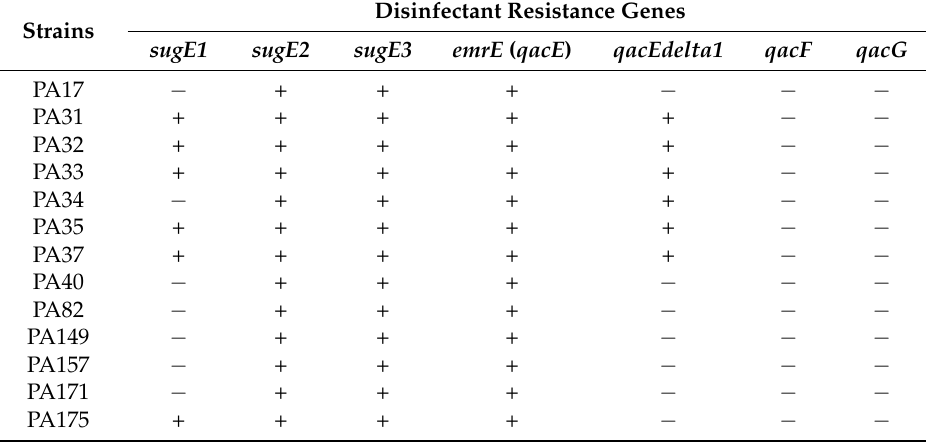
Table 1. Distribution of different disinfectant resistance genes in P. aeruginosa (+ = gene presence; − = gene